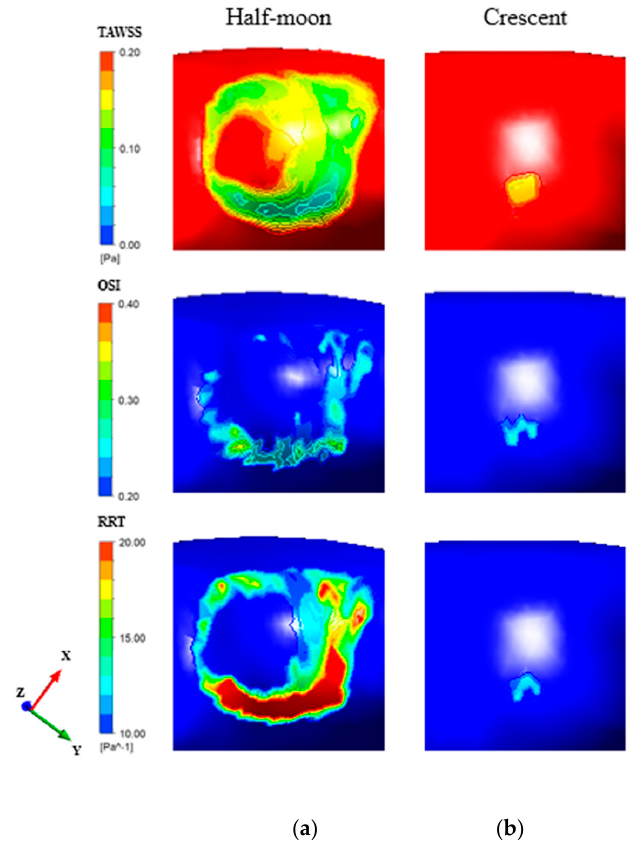
Figure 8. Distributions of TAWSS (< 0.2 Pa), OSI (> 0.2) and RRT (> 10 Pa − 1 ) for the half-moon-shaped ( a ) and crescent-shaped ( b ) pulmonary grafts: views from the bottom of the aortic arch.